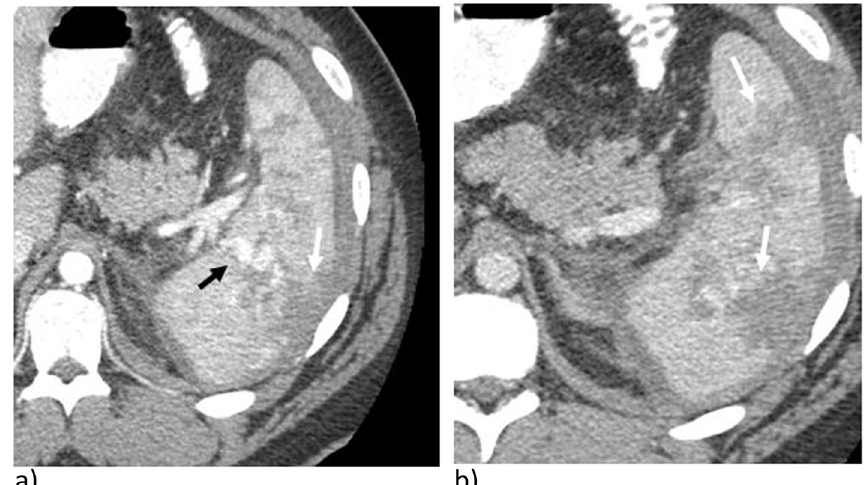
Fig. 2 CT in a trauma patient in a) mixed arterial and portal venous phase in a dual bolus injection and b) delayed phases demonstrating a grade IV splenic injury with large lacerations (solid white arrow) and pseudoaneurysms (solid black arrow). There is no extravasation of contrast as